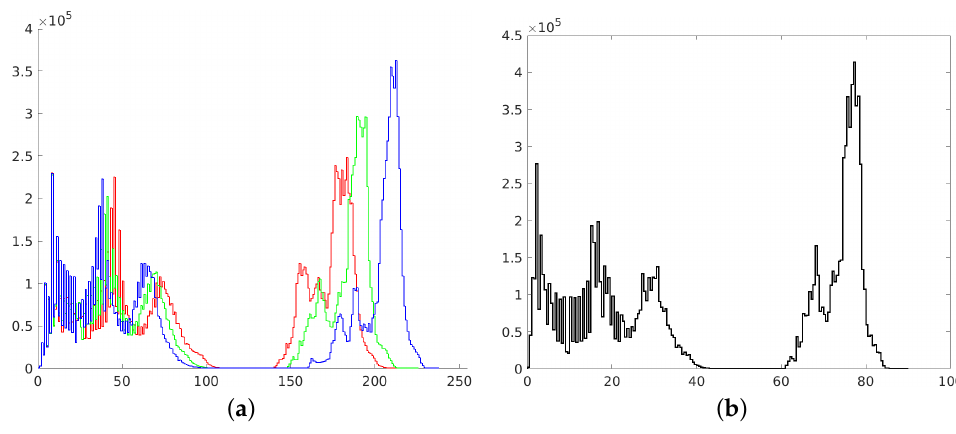
Figure 2. Histograms of RGB channels ( a ) and L channel of L*a*b* space ( b